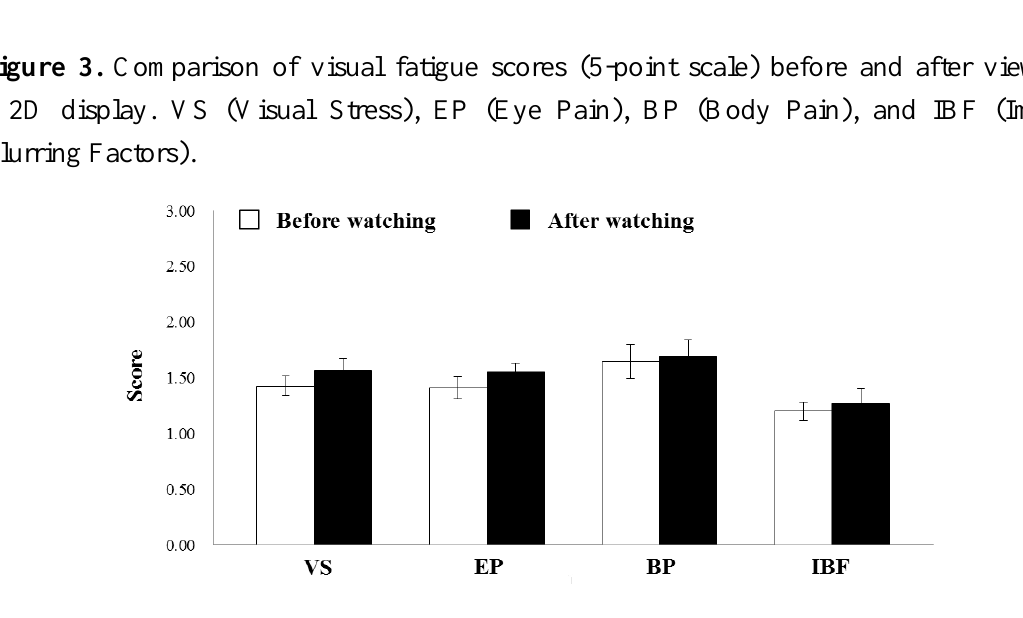
Figure 4. Comparison of visual fatigue scores (5-point scale) between before and after viewing a 3D display. (** and *** mean statistically significant at confidence level of 99% and 99.9%,